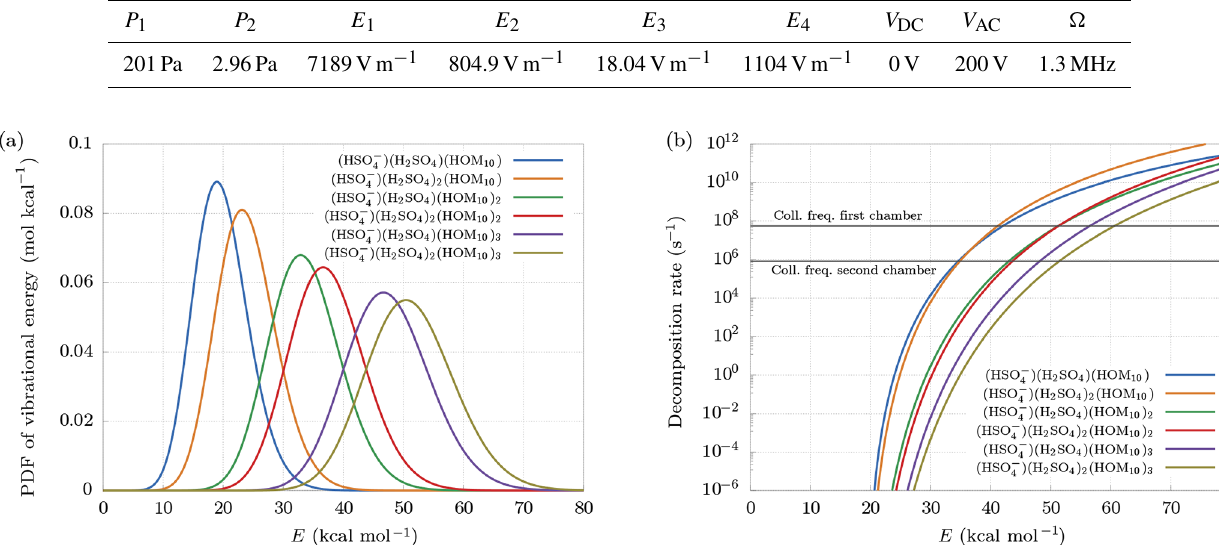
)( H 2 SO 4 )( HOM 10 ) cluster dynamics at E f = of ( HSO − 4 17 . 88 kcal mol − 1 , corresponding to a survival